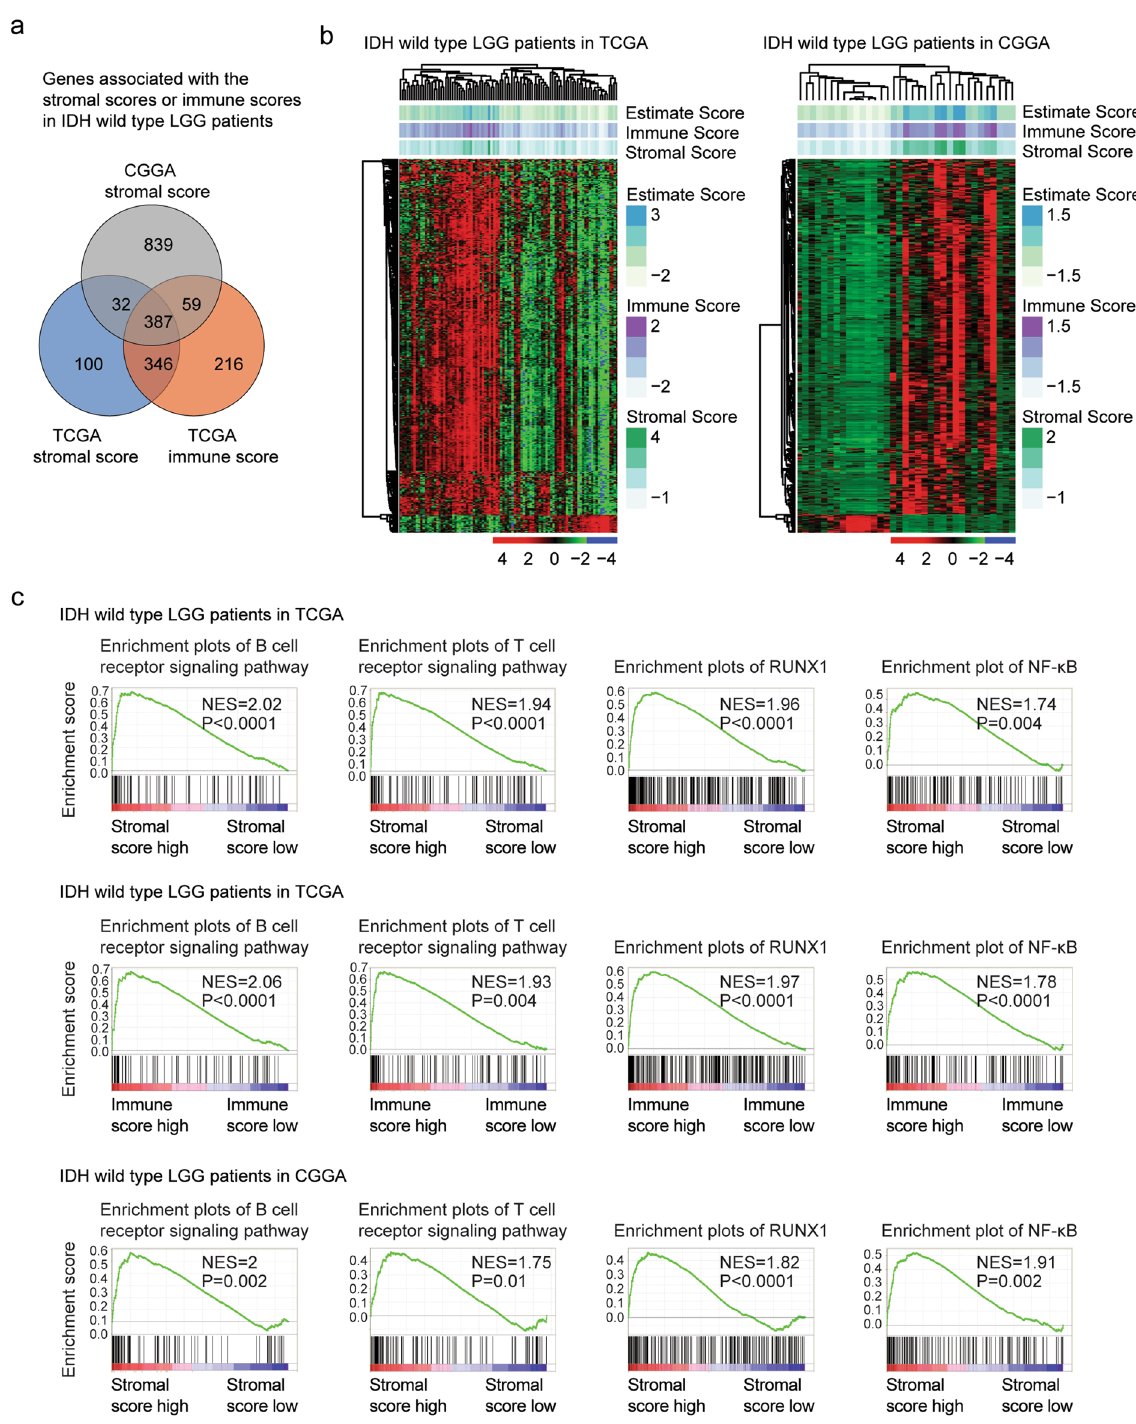
Figure 3. Transcriptional characteristics of of IDH wild type LGG patients with different immune infiltrations. ( a ) Overlapping the differentially expressed genes in IDH wild type LGG patients with different immune infiltrations in TCGA and CGGA datasets. ( b ) Un-supervised clustering heatmaps demonstrated the common differentially expressed genes in IDH wild type LGG patients with different immune infiltrations in TCGA and CGGA datasets. ( c ) Enrichment plots of B cell receptor signaling pathway, T cell receptor signaling pathway and RUNX1, NF-κB transcription factors in different stromal score and immune score IDH wild type LGG patients in TCGA and CGGA